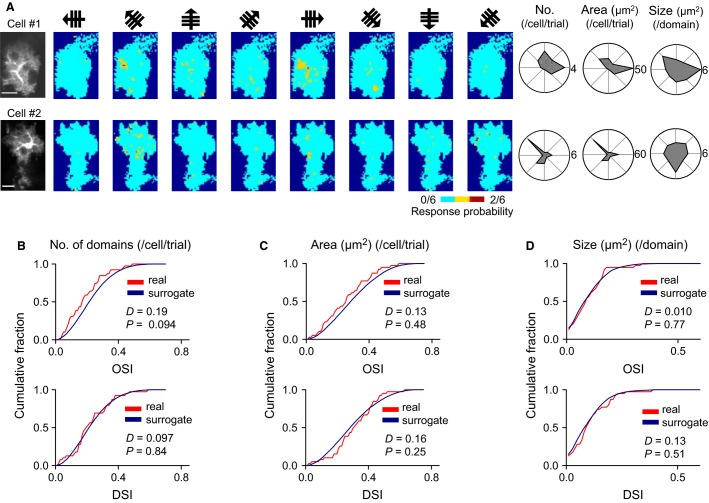
Nonsignificant orientation tuning of astrocytic calcium signals at the whole-cell level. (A), Maps of activated domains stacked over six sessions for each direction in two representative astrocytes (left). Scale bar=20 μm. The right polar plots for these two astrocytes indicate the number of activated domains per trial (No.), the total area of activated domains per trial (Area), and the mean size of individual domains (Size) for gratings with eight directions. (B–D), The cumulative distributions of OSIs and DSIs for the number of activated domains (B), the total area of activated domains (C), and the mean size of individual activated domains (D) were compared between real datasets (red) and their 1000 trial-shuffled surrogates (blue). The D and P values were determined using the Kolmogorov–Smirnov test. n = 39 astrocytes.